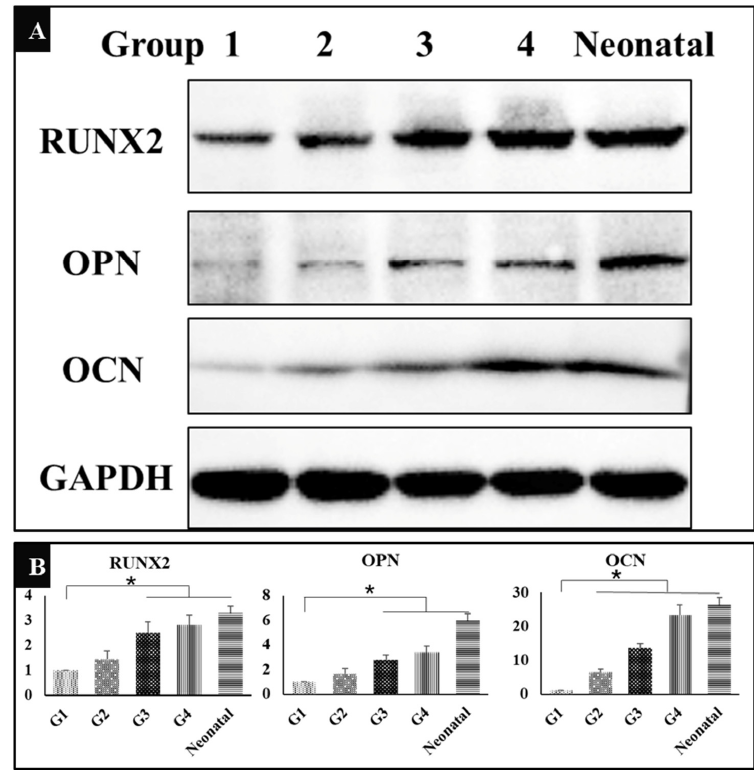
Figure 6. ( A ) Western Blot showing the expression of runt-related transcription factor-2 (RUNX2), osteopontin (OPN), osteocalcin (OCN), and GAPDH in five groups ( n = 3). G1: negative control group; G2: running group; G3: weight-bearing group; G4: positive control group; Neonatal: neonatal bone, control. ( B ) The corresponding gray-scale value of RUNX2, OPN, and OCN in the five groups ( n = 3)